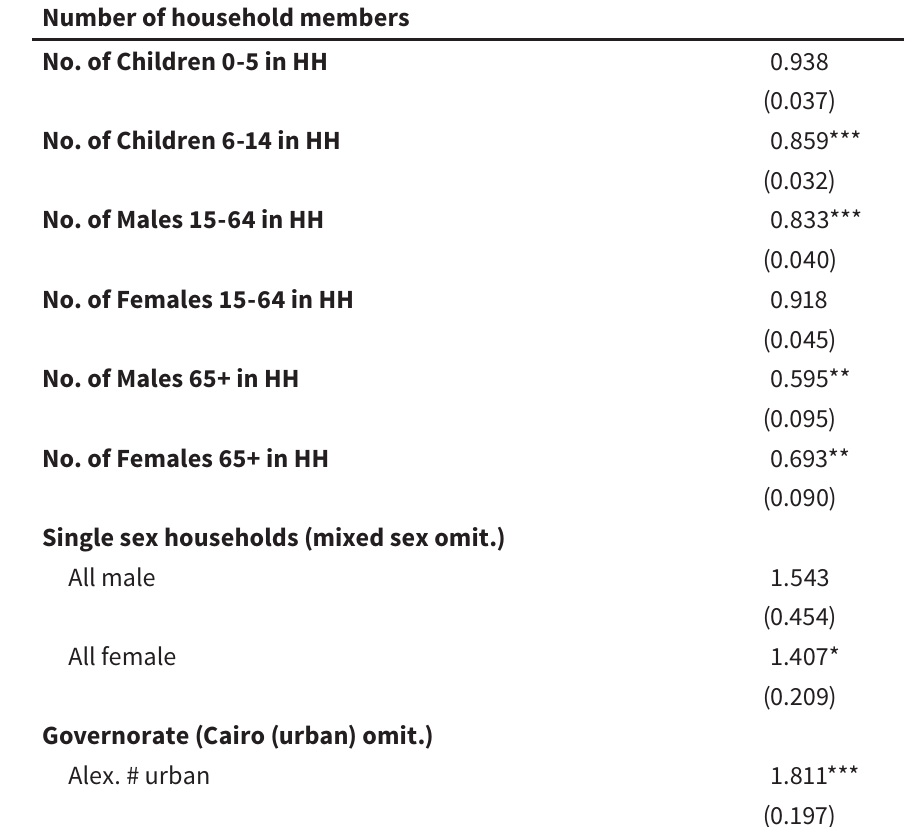
Type I attrition logit model: odds ratios for probability of attrition Number of household